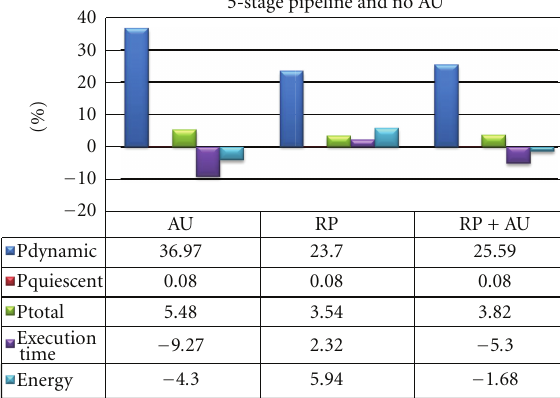
Table 10: Impact of the MicroBlaze configurations for the NCC algorithm at 100MHz for V5LX110T.